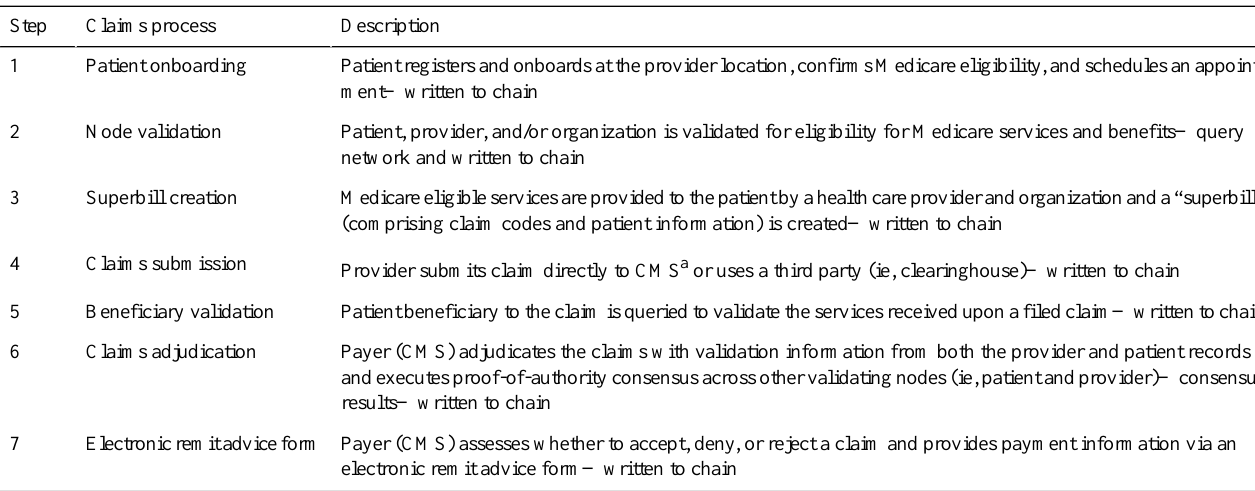
Table 1. Description of mapping the framework’s smart contract processes to the Centers for Medicare and Medicaid Services general claims adjudication